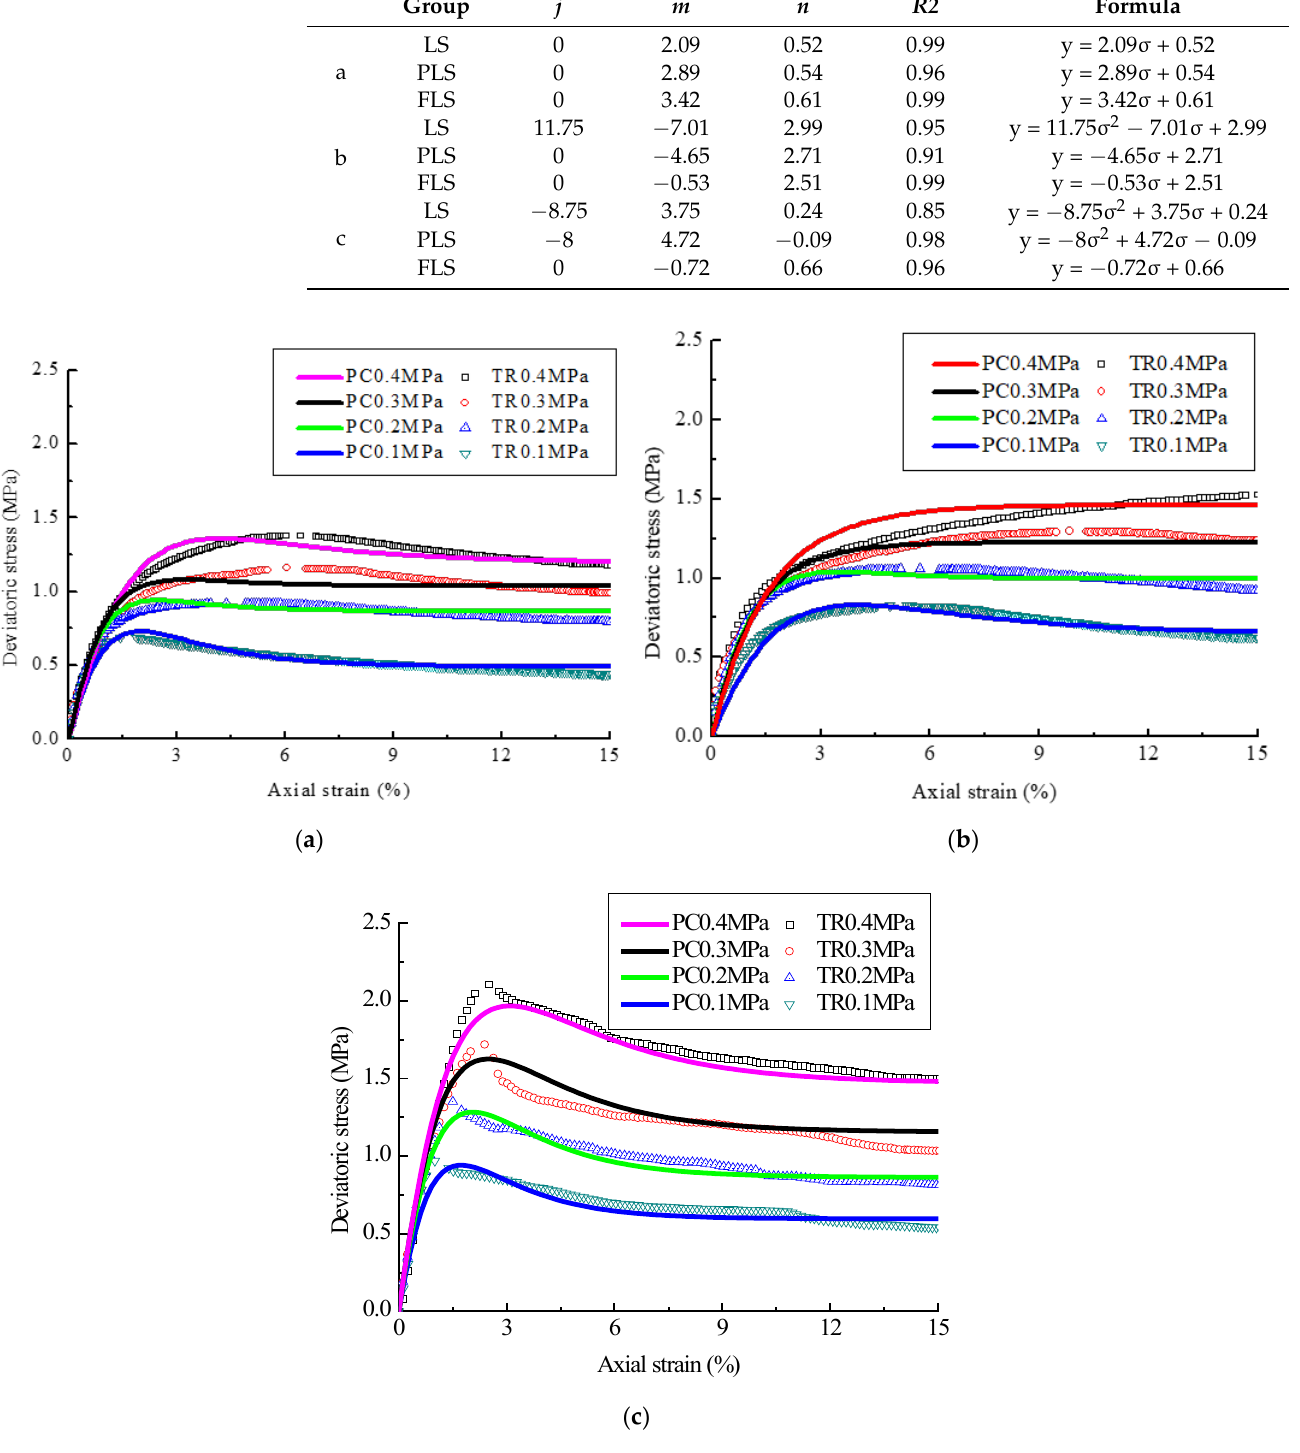
Figure 5. CSE prediction model verification. ( a ) LS sample; ( b ) PLS sample; ( c ) FLS sample.